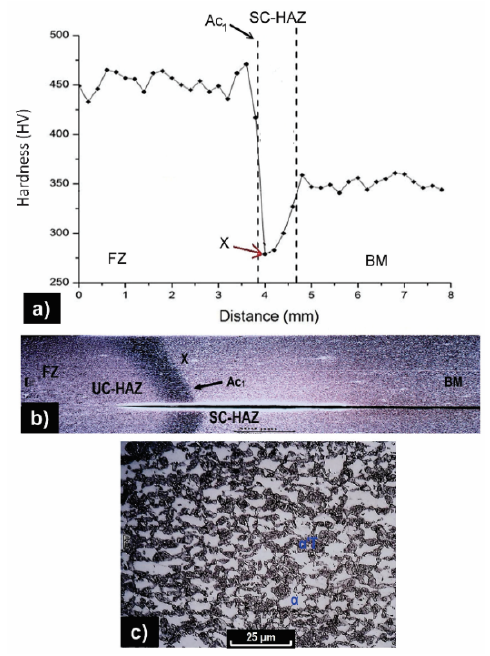
Figure 6. Resistance Spot Welding of DP980 steel: ( a ) microhardness indentations profile across the weldment, ( b ) weld cross-section showing the sub-critical HAZ, ( c ) microstructure revealing martensite tempering located just beside the Ac 1 line (obtained from